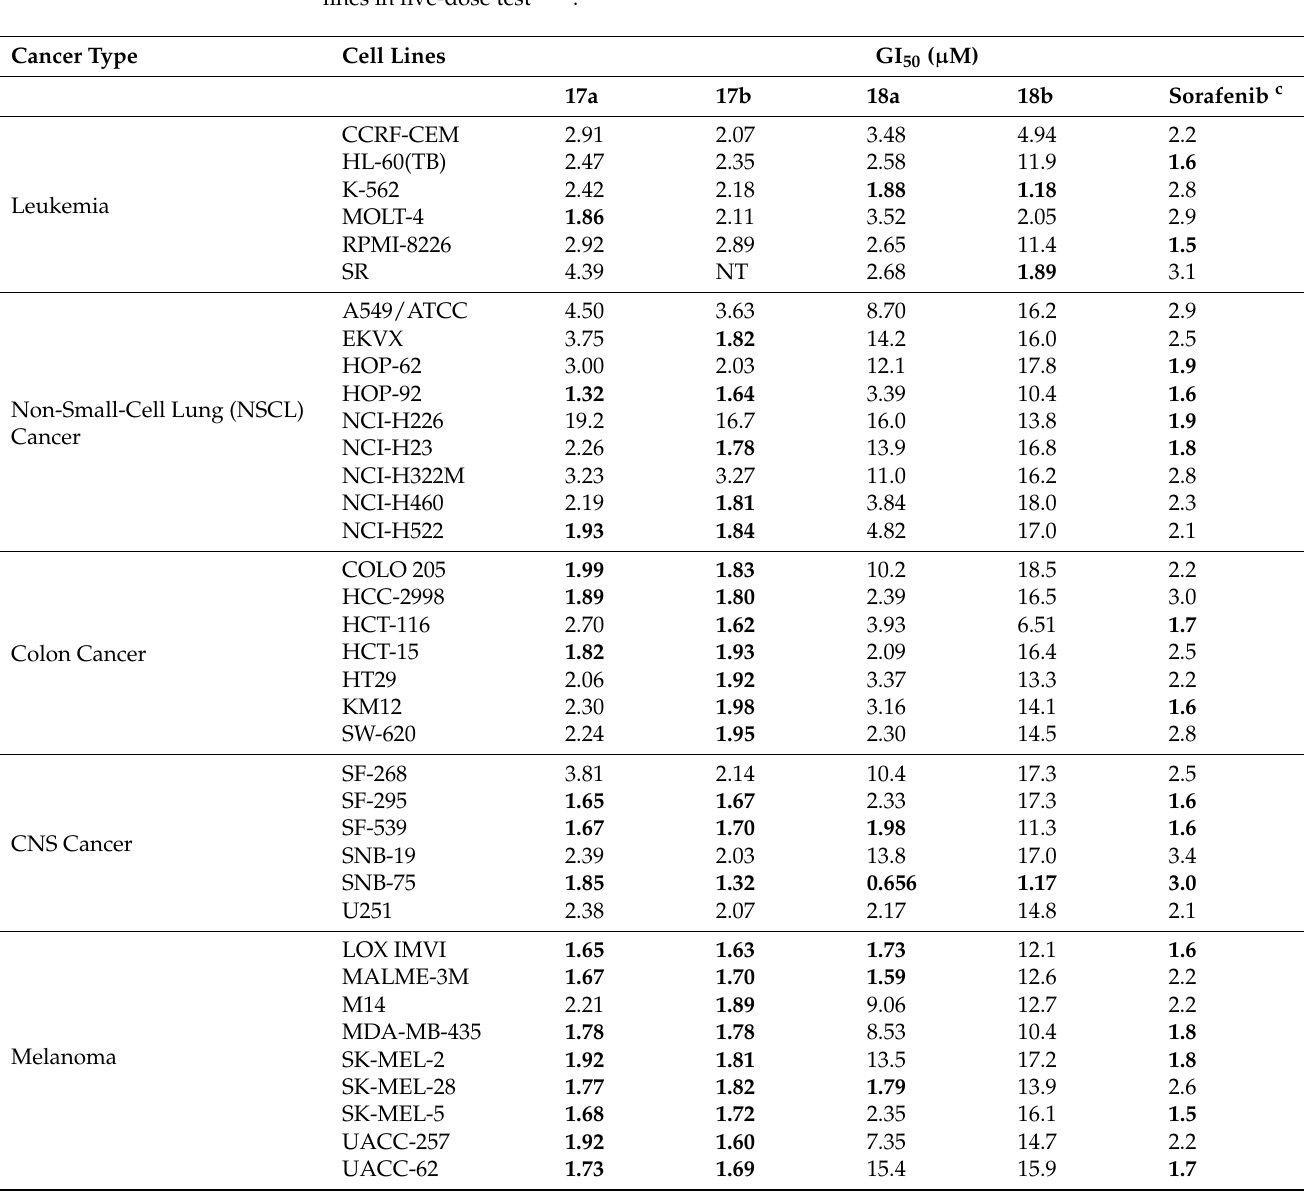
Table 4. GI 50 ( µ M) of compounds 17a , 17b , 18a , 18b , and Sorafenib against NCI-60 human tumor cell lines in five-dose test a,b,c